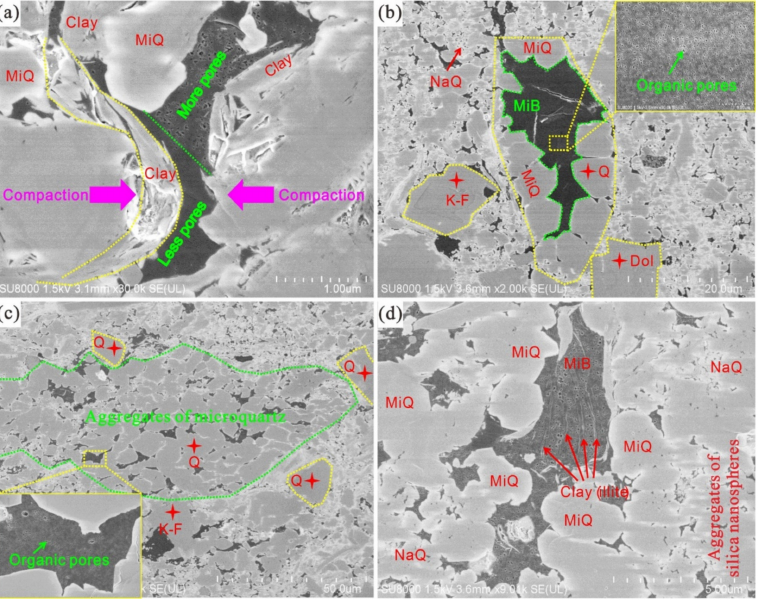
Figure 7. SEM photographs showing different mineral compositions and pore characteristics of OM. Samples were from Wufeng–Longmaxi Formation shale in Well PS-1. Points delineated by red stars were analyzed by EDS. (Explanation: SB = solid bitumen; Q = quartz; K-F = K-feldspar.) ( a ) Compaction induced the deformation of clay minerals and the collapse of pores, while quartz may work against compaction, and organic pores were largely preserved [159]. ( b ) Microquartz aggregate consisting of euhedal microquartz crystals; the SB within the microquartz aggregate was porous [159]. ( c ) The SB between microquartz aggregates was porous [159]. ( d ) The SB between the microquartz grains was porous, and some clay minerals (probably illite) displayed an oriented distribution in the SB, indicating that the rigid framework formed by microquartz grains worked against the compaction [159]. The four photographs are from